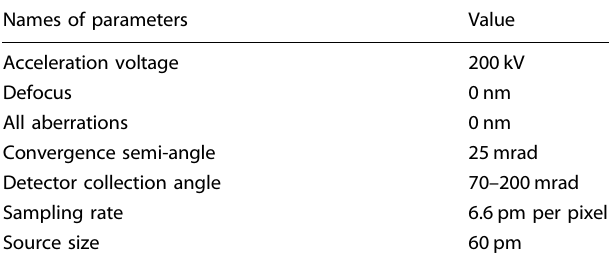
Table 1. Parameters for HAADF – STEM